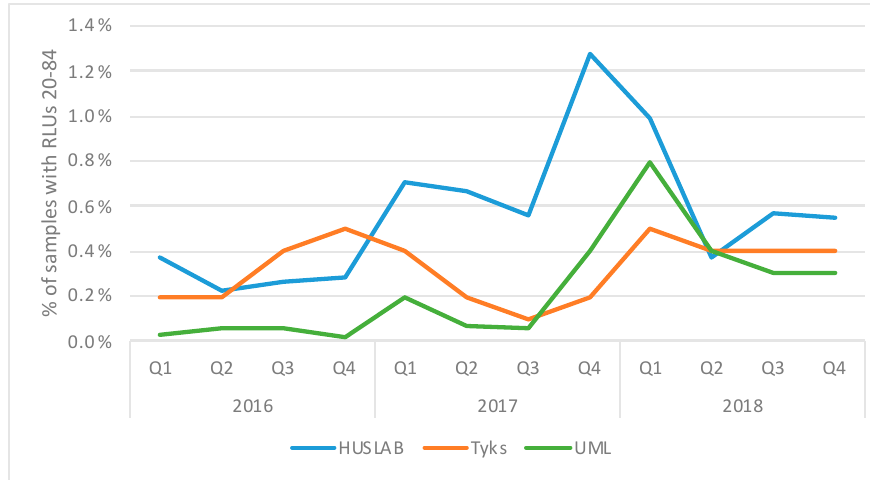
Figure 3. Quarterly proportions of Aptima Combo 2 specimens yielding relative light unit (RLU) 20– 84 and flagged negative for C. trachomatis in three diagnostic laboratories in Finland in 2016–2018. The total number of specimens included was 212,000 (HUSLAB) and 66,000 (Tyks). The number of UML samples was not available.